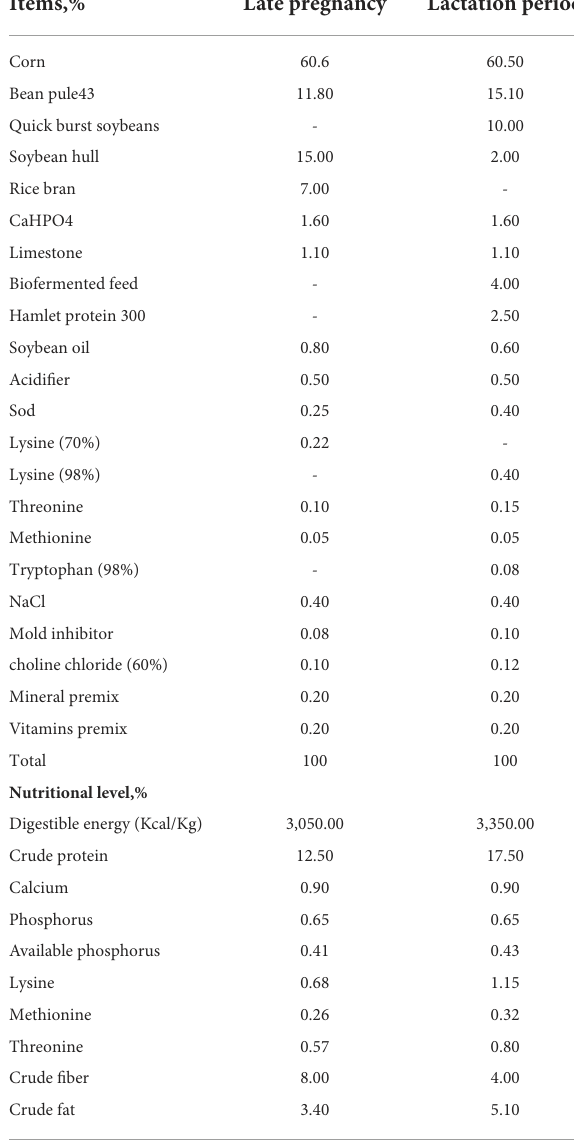
TABLE 1 Composition and nutrient levels of the basal diet (air-dry